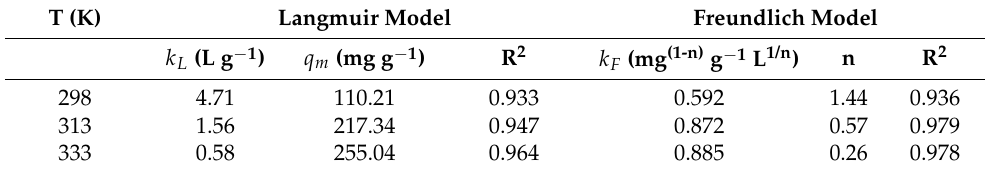
Table 4. Parameters of Langmuir and Freundlich isotherm models at 298, 313, and 333 K. T (K)